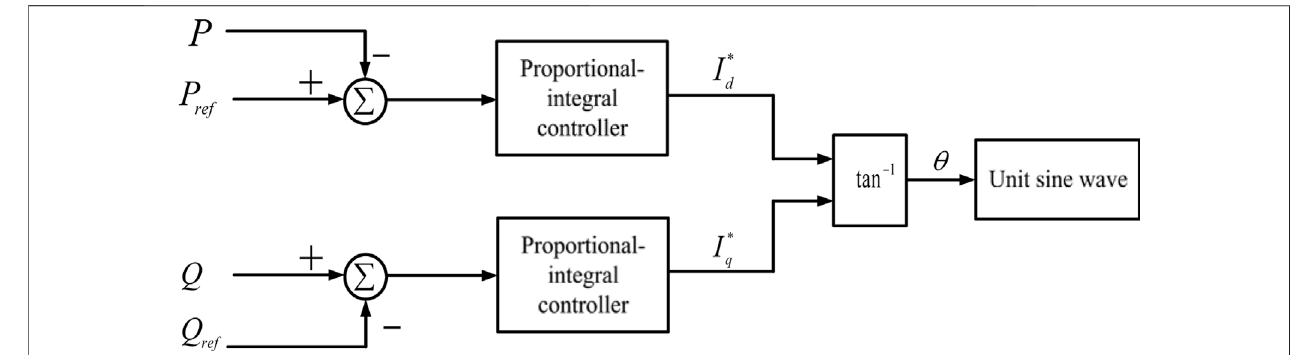
FIGURE 6 | The architecture for controlling the phase angle difference of the output voltage and current of the smart inverter.